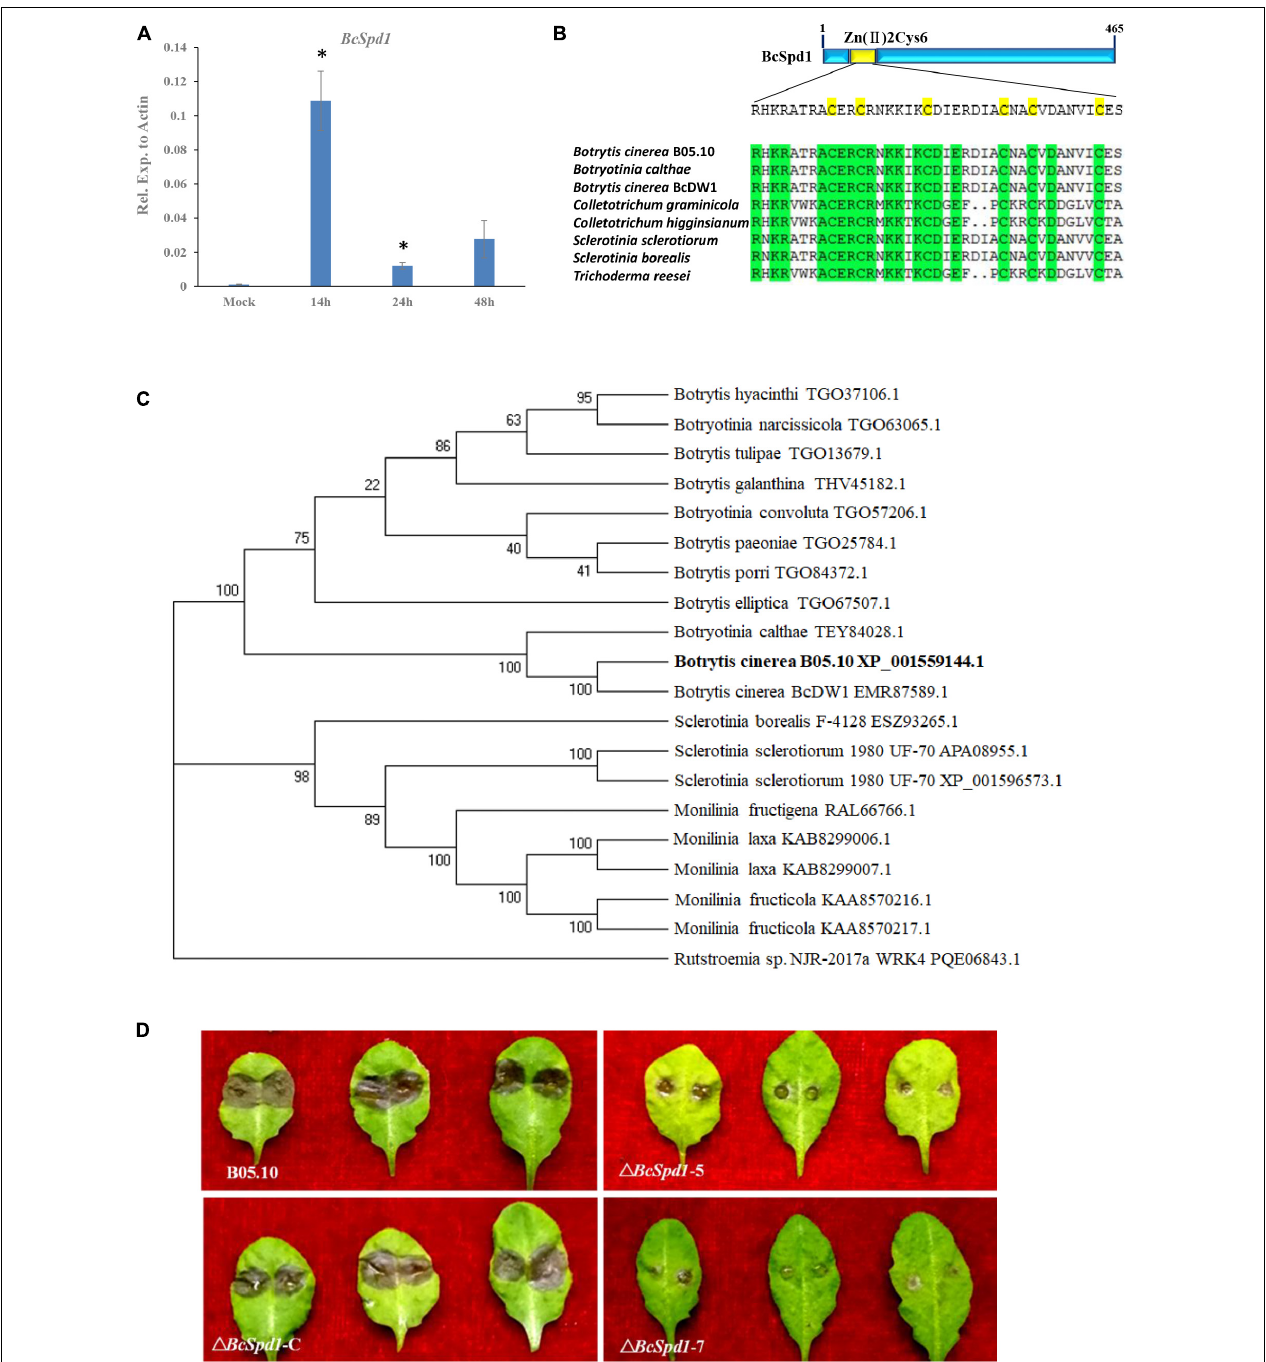
FIGURE 1 | Identification and characterization of BcSpd1 in B. cinerea . (A) qRT-PCR analysis of BcSpd1 gene expression in B. cinerea during fungus infection of the ginseng plant at different timepoints. (B) Zn 2 Cys 6 domain alignment of the BcSpd1 and the indicated species. (C) Phylogenetic tree of BcSpd1 proteins and the indicated proteins including Botrytis cinerea BcDW1 (EMR87589.1), Botrytis elliptica (TGO67507.1), Botrytis porri (TGO84372.1), Botrytis paeoniae (TGO25784.1), Botrytis galanthina (THV45182.1), Botrytis tulipae (TGO13679.1), Botrytis hyacinthi (TGO37106.1), Botryotinia calthae (TEY84028.1), Botryotinia convoluta (TGO57206.1), Botryotinia narcissicola (TGO63065.1), Sclerotinia borealis F-4128 (ESZ93265.1), Sclerotinia sclerotiorum 1980 UF-70 (APA08955.1), Sclerotinia sclerotiorum 1980 UF-70 (XP_001596573.1), Monilinia fructigena (RAL66766.1), Monilinia laxa (KAB8299006.1), Monilinia laxa (KAB8299007.1), Monilinia fructicola (KAA8570216.1), Monilinia fructicola (KAA8570217.1), and R utstroemia sp. NJR-2017a WRK4 (PQE06843.1). (D) (cid:49) BcSpd1 shows reduced disease symptoms on Arabidopsis thaliana Col-0 leaves. Photographs were taken 3 days post-infection. Wild-type strain B05.10 presents large lesions compared with (cid:49) BcSpd1-5 - and (cid:49) BcSpd1-7 -infected leaves that show small lesions or no necrotic symptoms on leaves. The complement line (cid:49) BcSpd1- C recovered from wild-type pathogenicity.